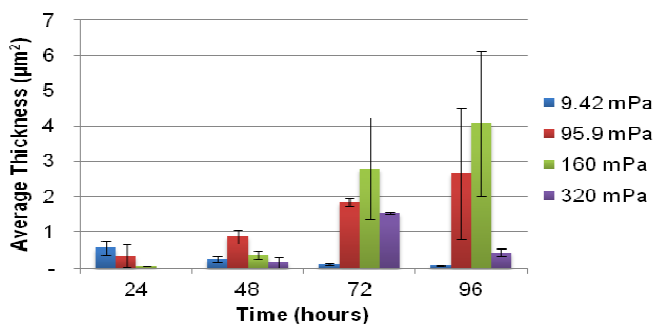
Figure 2. The average thickness of microfluidic channel biofilms as determined by COMSTAT analysis of replicate confocal scanning laser microscopy (CLSM)